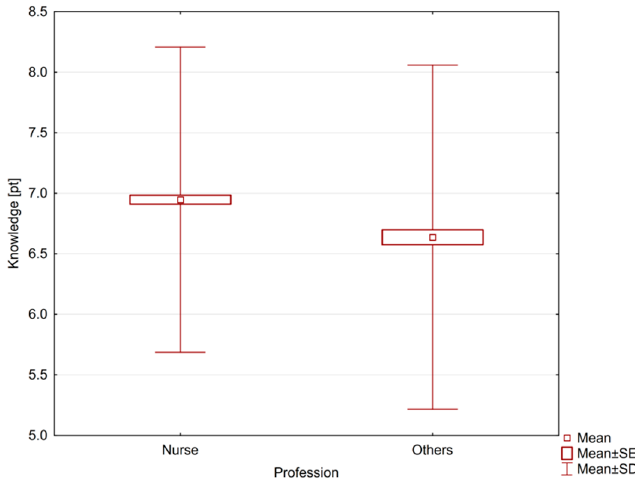
Figure 1. The level of knowledge of nurses and other medical